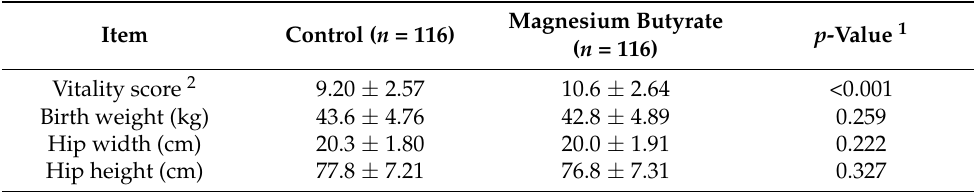
Table 3. Birth related parameters of dairy calves born to Control and Magnesium butyrate dams (means ± standard